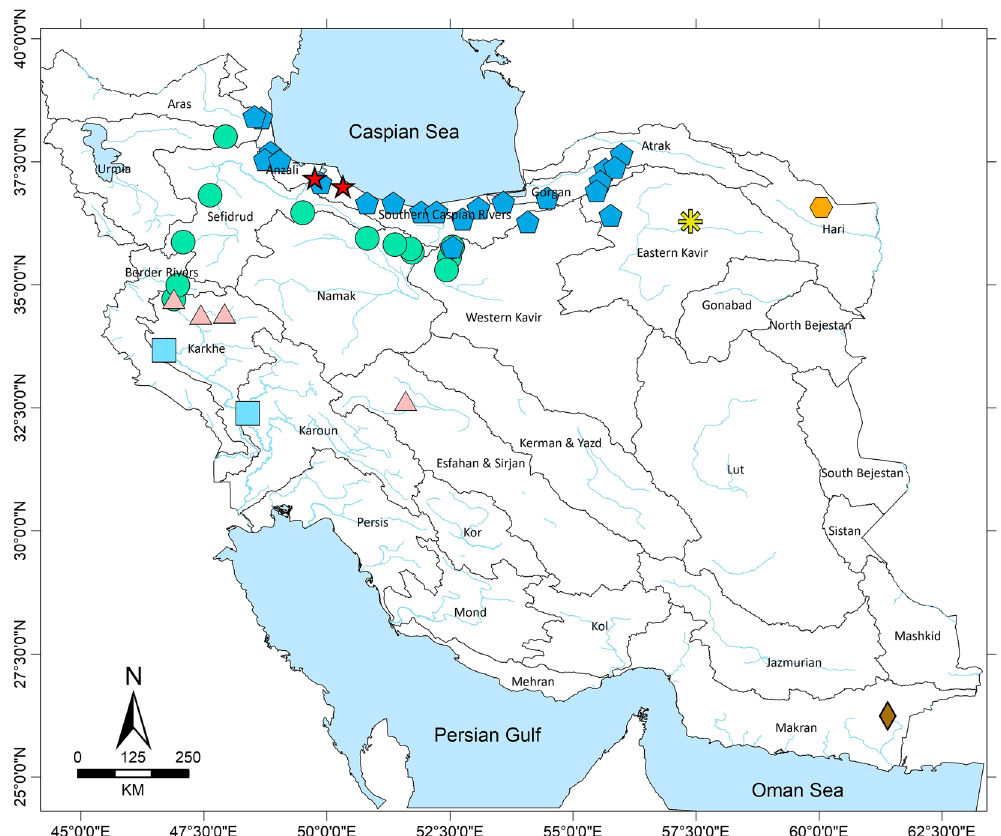
Figure 1. The sampling map of the studied populations. Points marked with an blue pentagon represent P. ibericum , red star P. bilobatum , green circle P. elbursi , pink triangle P. persicum , light blue rectangle P. ilam , yellow asterisk P. transcaspicum , orange hexagon P. ruttneri and brown diamond P. gedrosianum . The colours used for each species correspond to the same colours used in Fig. 2. The map was created using the software ArcGIS